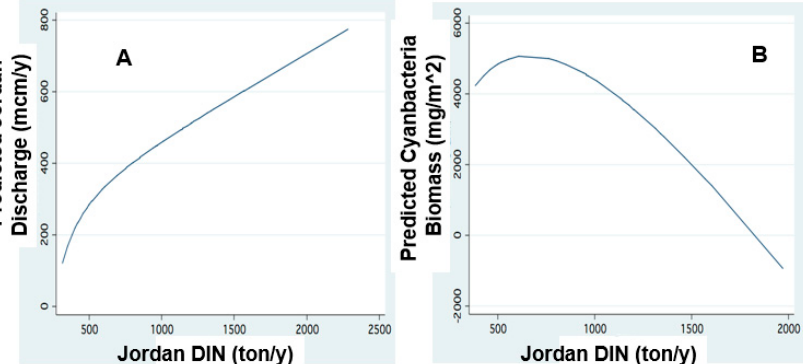
9 of 20 Figure 12. Temporal changes of Residence Time length in Lake Kinneret: FP regression between